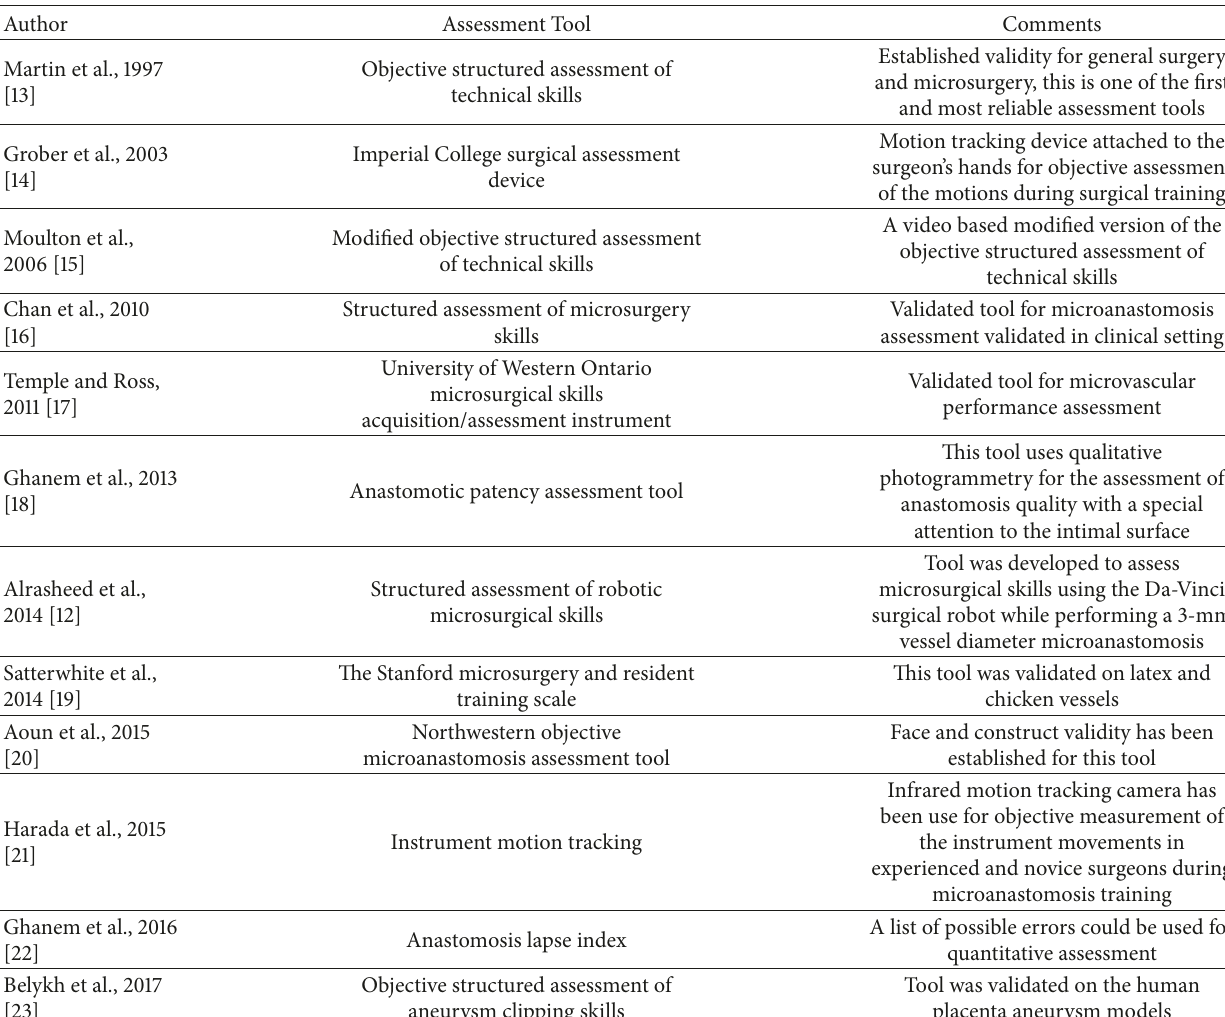
Table 2: Tools for microvascular anastomosis performance